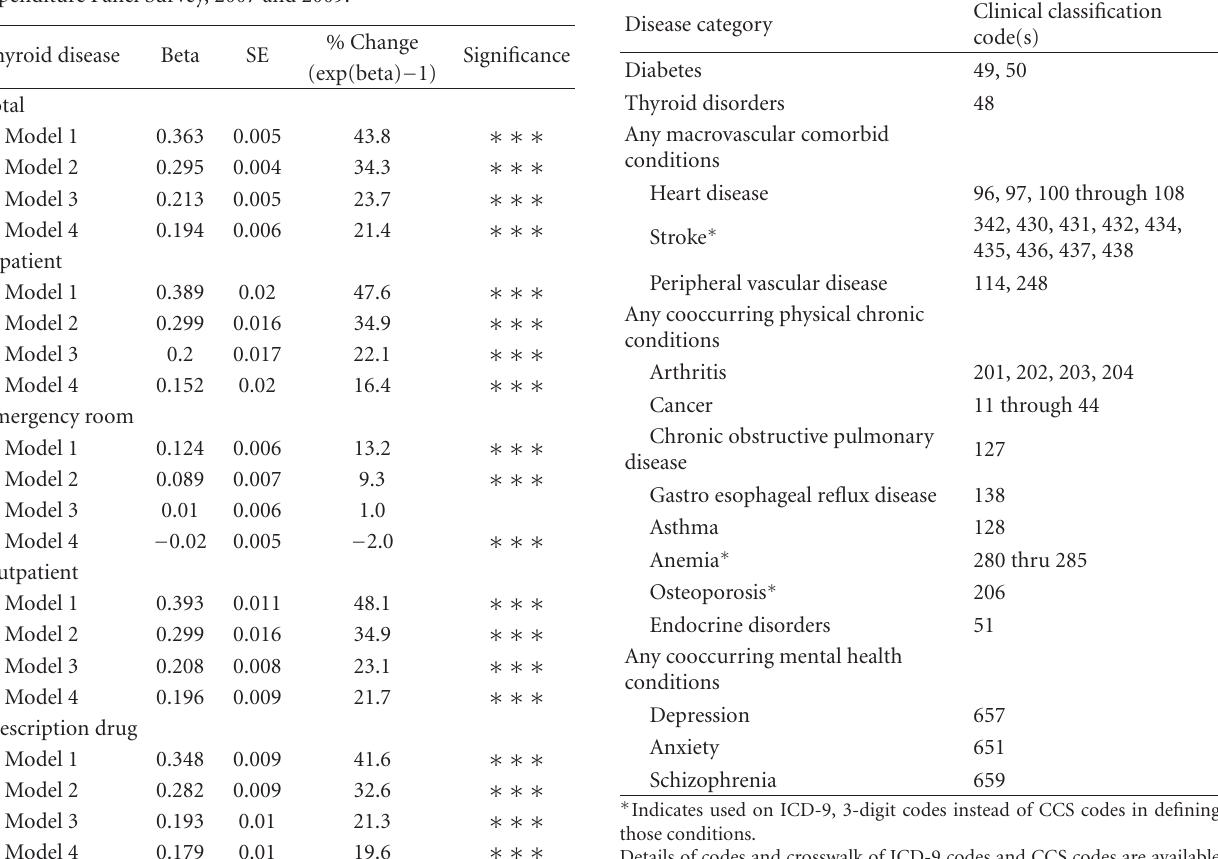
Table 4: Intercept and parameter estimates for the presence of thyroid disorders from ordinary least squares regression on logged healthcare expenditures individuals with diabetes from the Medical Expenditure Panel Survey, 2007 and 2009.